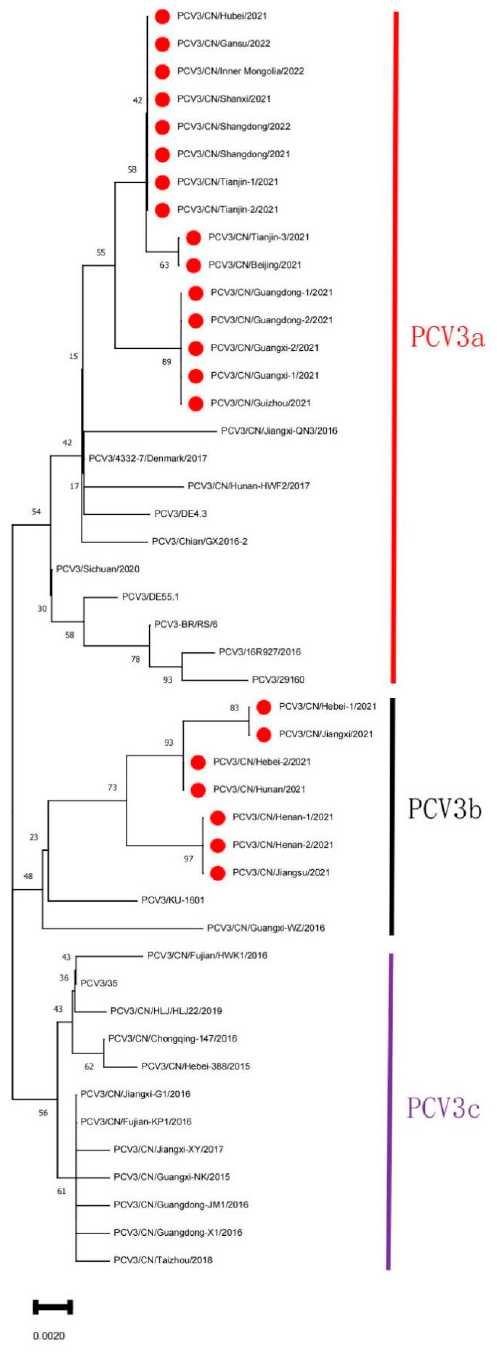
Figure 2. Phylogenetic analysis of the ORF2 gene of PCV3 strains. The PCV3 sequences were aligned by using Lasergene software with the Clustal W program for homology analysis. The evolutionary history was inferred by using the neighbor-joining method in MEGA11 software [24], and an ML tree by using over 10,000 bootstrap iterations to represent the evolutionary history of the taxa analyzed [25]. This analysis involved 46 nucleotide sequences, including the 22 PCV3 strains identified in our study and 24 PCV3 reference strains downloaded from the NCBI. Red circles represent PCV3 strains obtained in this